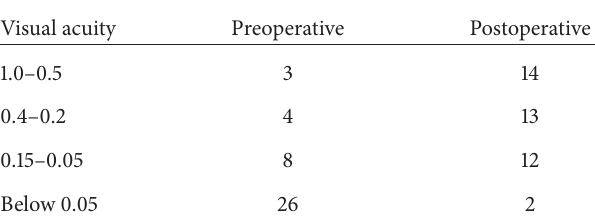
Table 2: Changes of best-corrected visual acuity for 41 successful